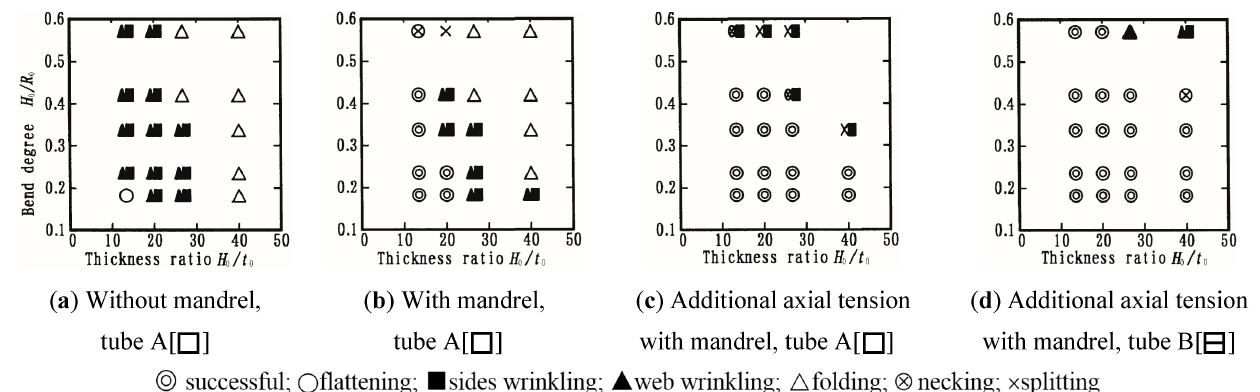
Figure 7. Effects of mandrel and axial tension in the rotary draw bending process. Reproduced with permission from ref. [31]. Copyright 2002 Elsevier Science B.V.